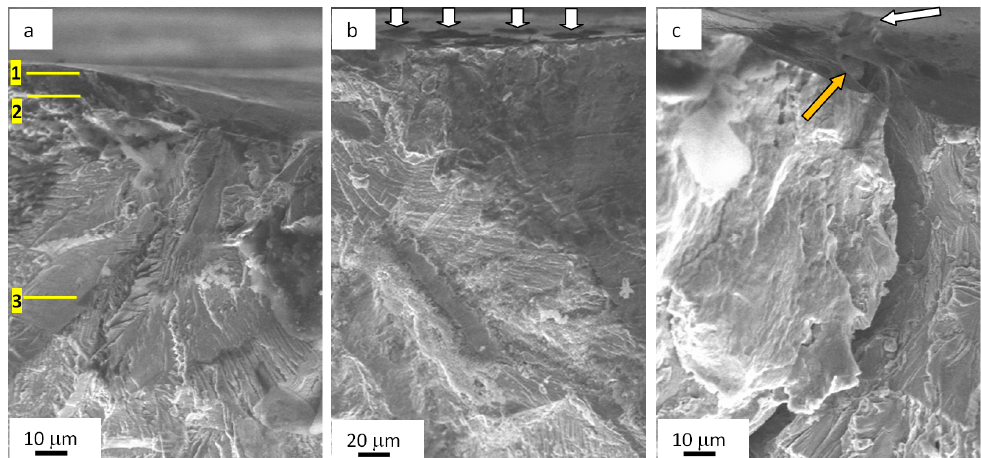
Figure 8. Fractography of the fatigue-fractured surface in AISI 310S steel treated with an electron beam and fractured when fatigue testing. The data in ( a ) present TEM-explored layers of a sample; arrows ( b ) highlight microcraters on the surface treated with an electron beam; a light arrow ( c ) points at a microcrater causing the formation of a mainstream macrocrack, and a color arrow indicates second-phase fragments.